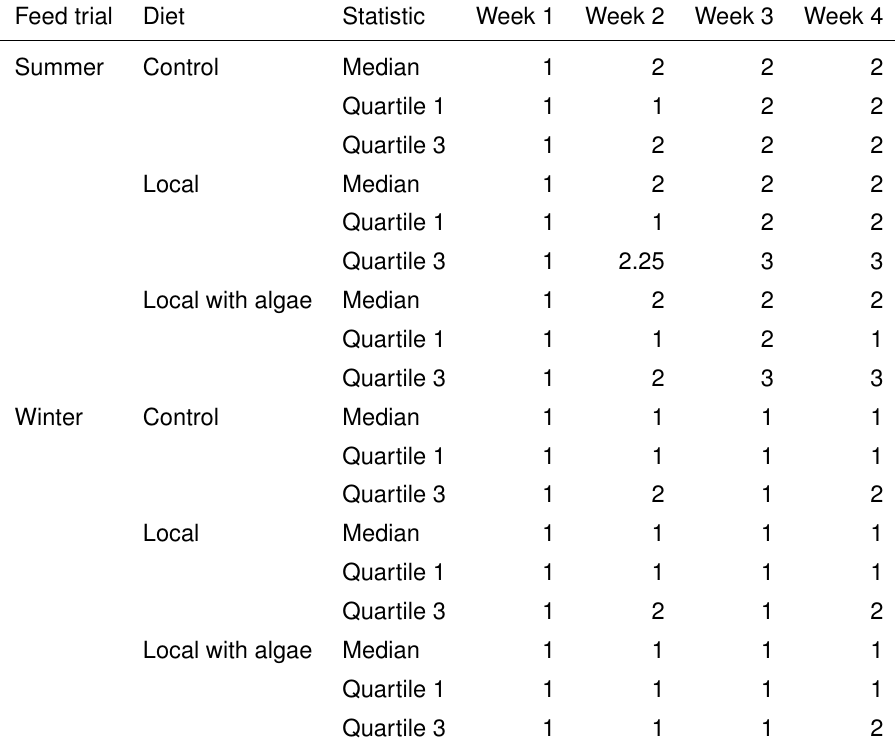
Table 5. Breast feather coverage data for the summer and winter feed trials. The scale is as follows: 1 for fully feathered, 2 for some feather loss, 3 for some feather coverage and 4 for no